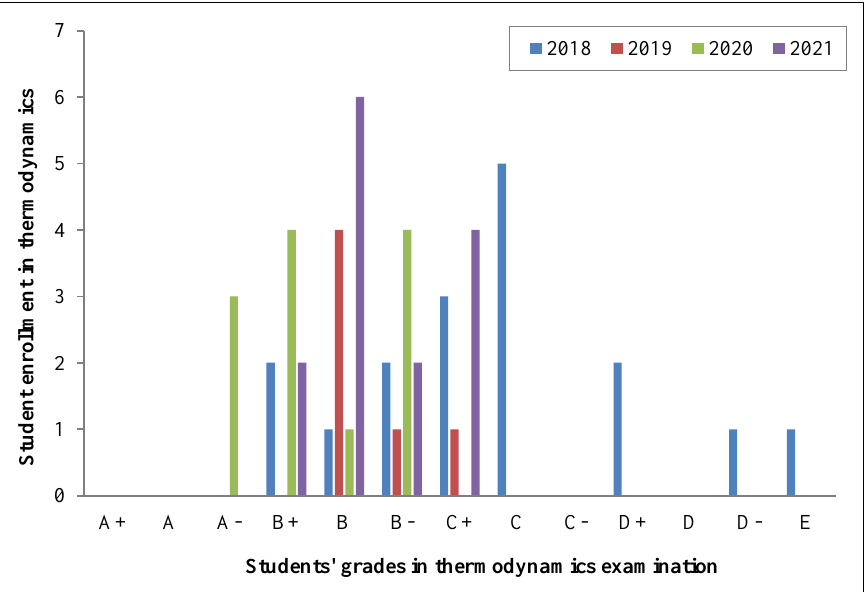
Figure 5. Grade distribution in Thermodynamics course across 4 years RQ3: Does mode of instruction significantly influence academic performance of engineering students in